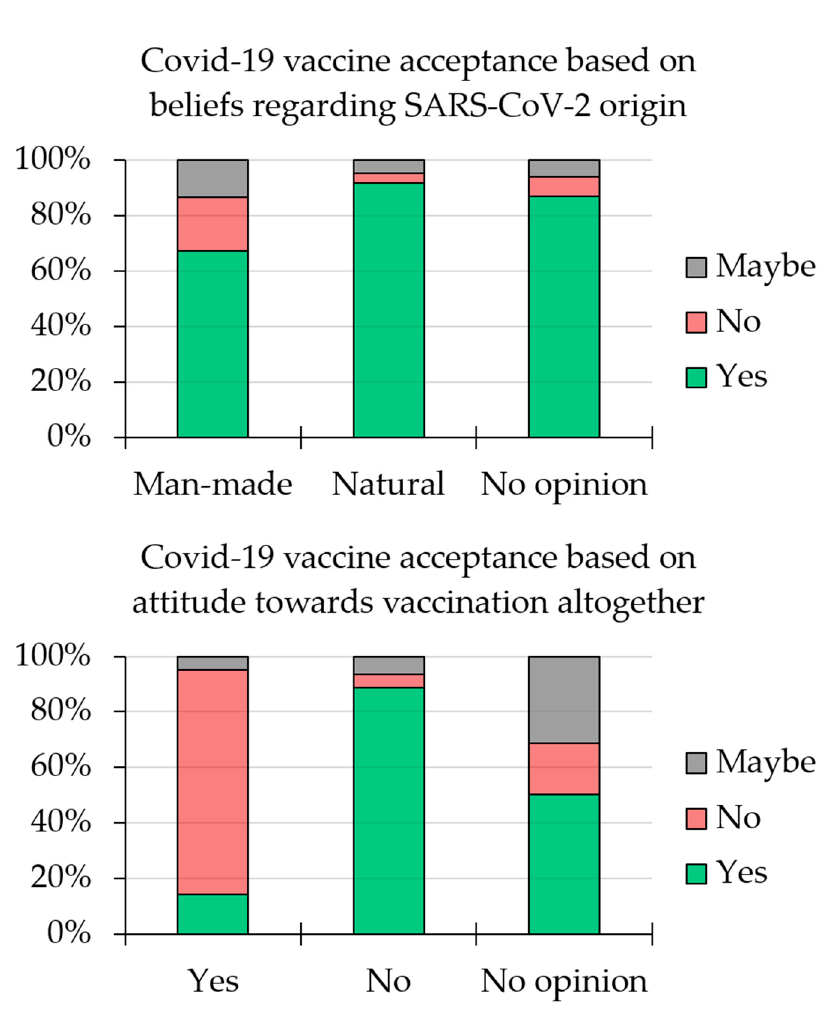
Figure 3. Intent to receive COVID-19 vaccination based on belief regarding virus origin and general attitude toward